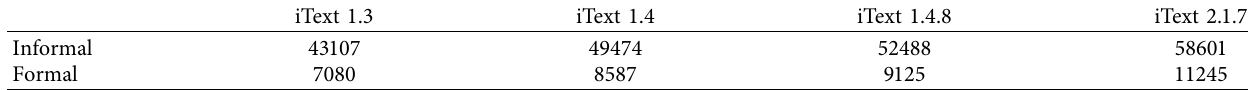
Table 6: Formal and informal relationship in iText.